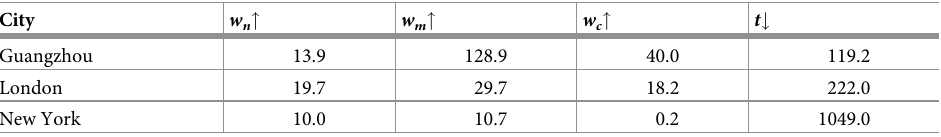
and t denote the c